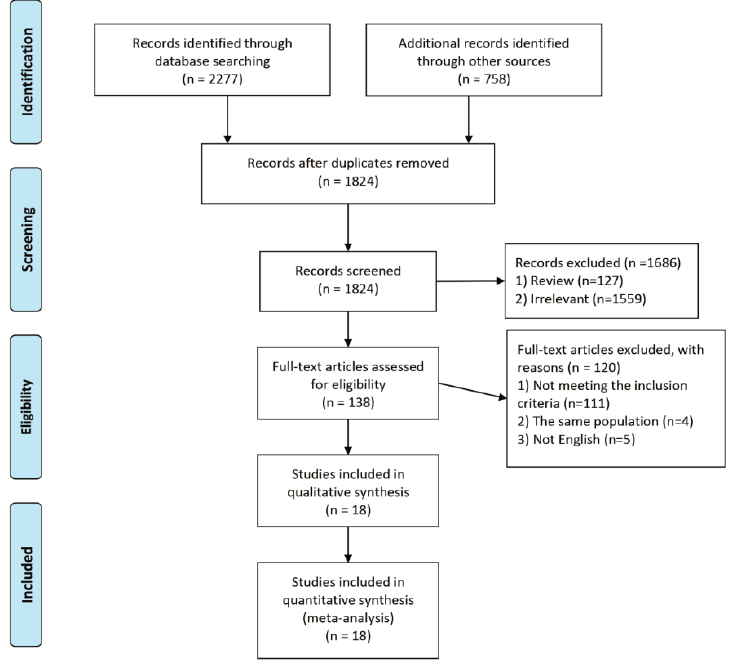
Figure 1. Study flow diagram.